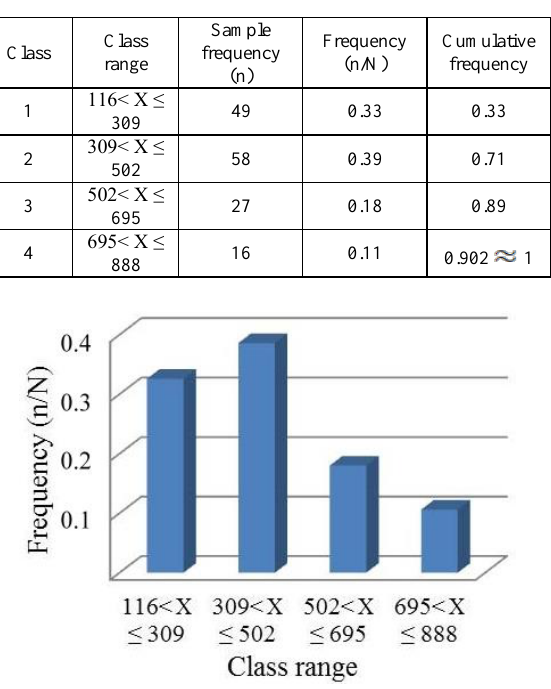
Table 4. Frequency analysis of influent COD